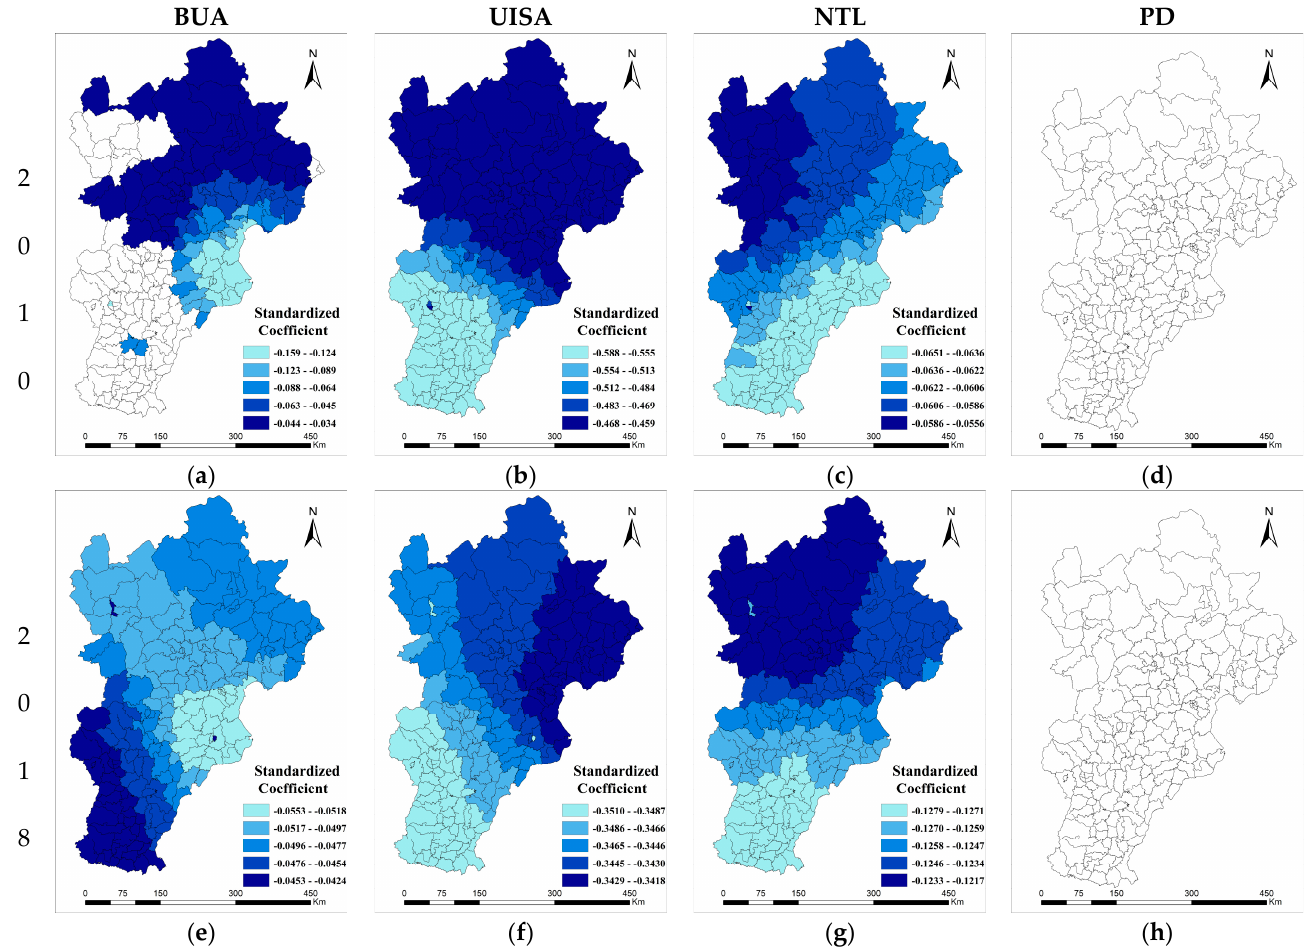
Figure 5. Spatial heterogeneity of the impact of urbanization factors on carbon storage. The first and second rows represent the results for 2010 and 2018, respectively. ( a , e ): BUA; ( b , f ): UISA; ( c , g ): NTL; ( d , h ): PD. Please see Table S1 for an explanation of each abbreviation in this figure.